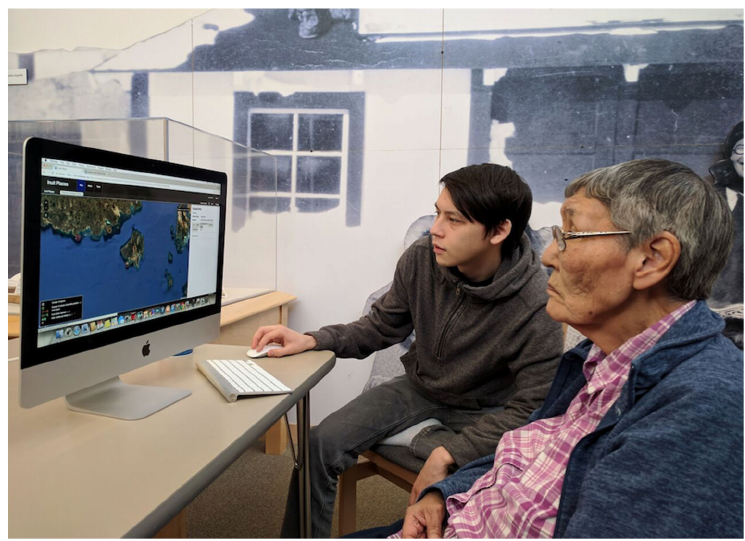
Figure 10. A Cambridge Bay student is partnered with Mabel Etegik to assist with navigation and content entry in the Kitikmeot Place Names Atlas.